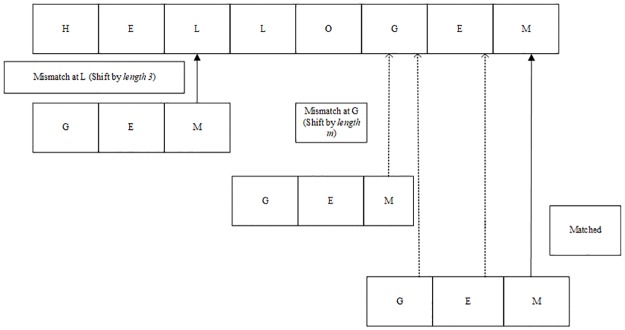
Boyer Moore algorithm [7].